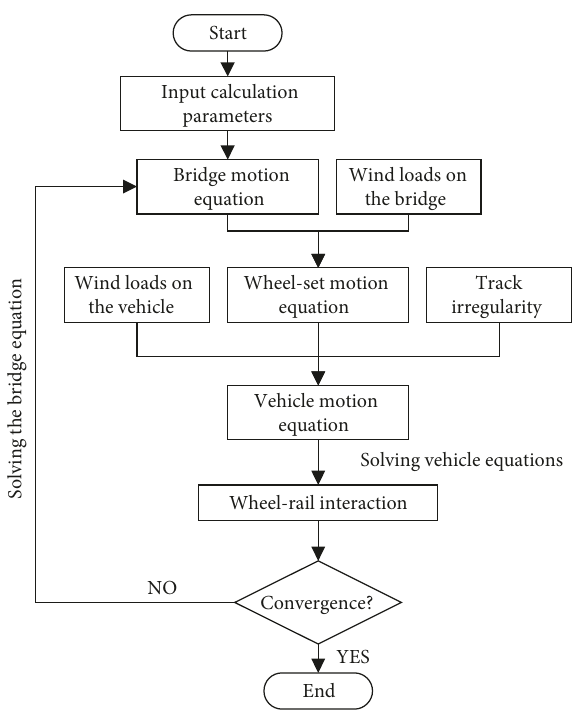
Figure 6: Flowchart of intersystem